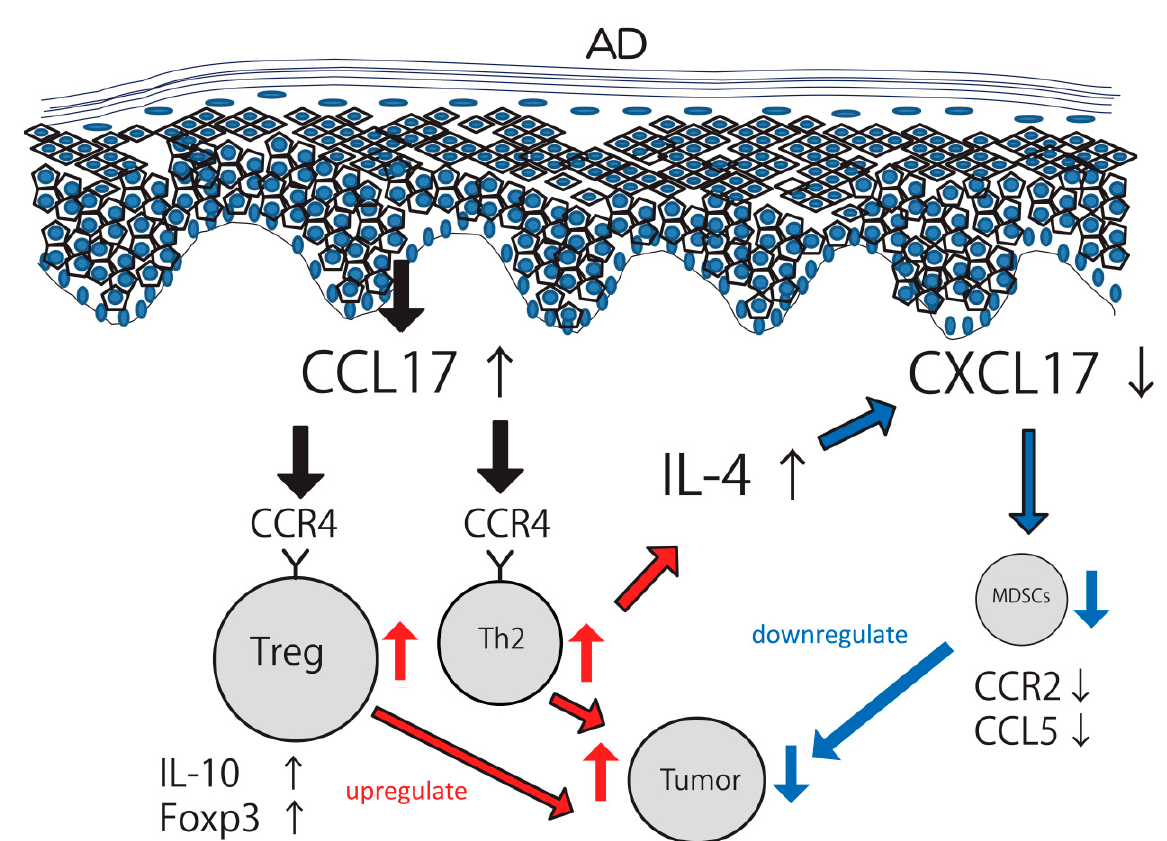
Figure 7. Schema describing relationship among regulatory T cells (Tregs), Th2 cells, and myeloid-derived suppressor cells (MDSCs) in atopic dermatitis (AD). CCL17 is overexpressed in AD and recruits CCR4 + cells such as Tregs and Th2 cells into the tumor microenvironment. Tregs, producing IL-10 and Foxp3, attenuate tumor immunity and increase tumor formation. IL-4, which is produced by Th2 cells, downregulates CXCL17 expression. Decreases in CXCL17 lead to reduced frequency of MDSCs, which results in enhanced tumor immunity. Tumor formation is determined by the balance between positive regulation of Tregs and negative regulation of MDSCs.